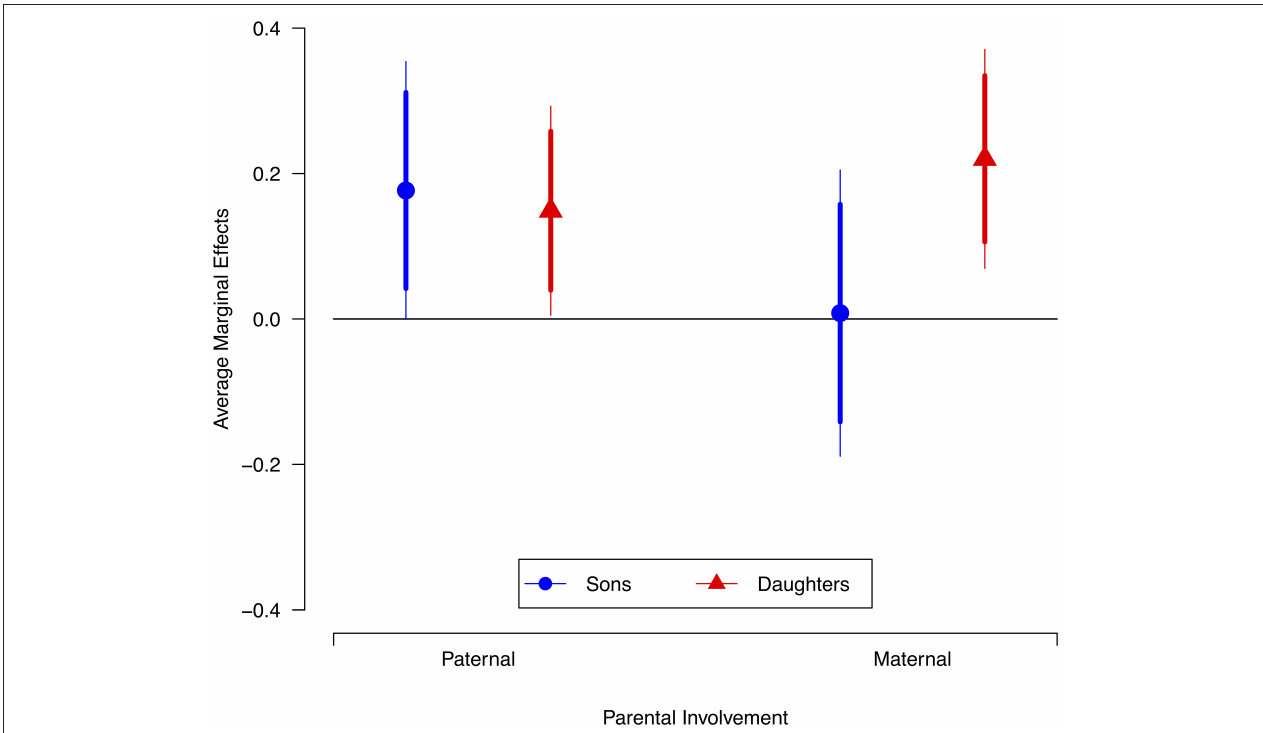
FIGURE 2 | Average marginal effect of parental involvement on the life satisfaction of sons and daughters. Brackets show confidence intervals (thicker lines 95%; thinner lines